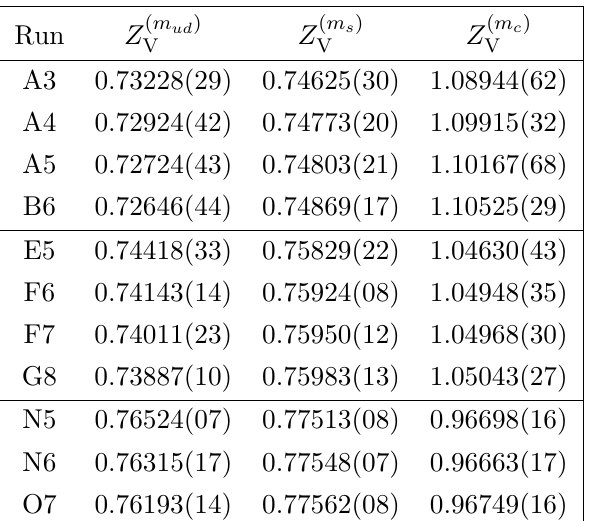
de(cid:12)ned in eq. (A.5), com- V